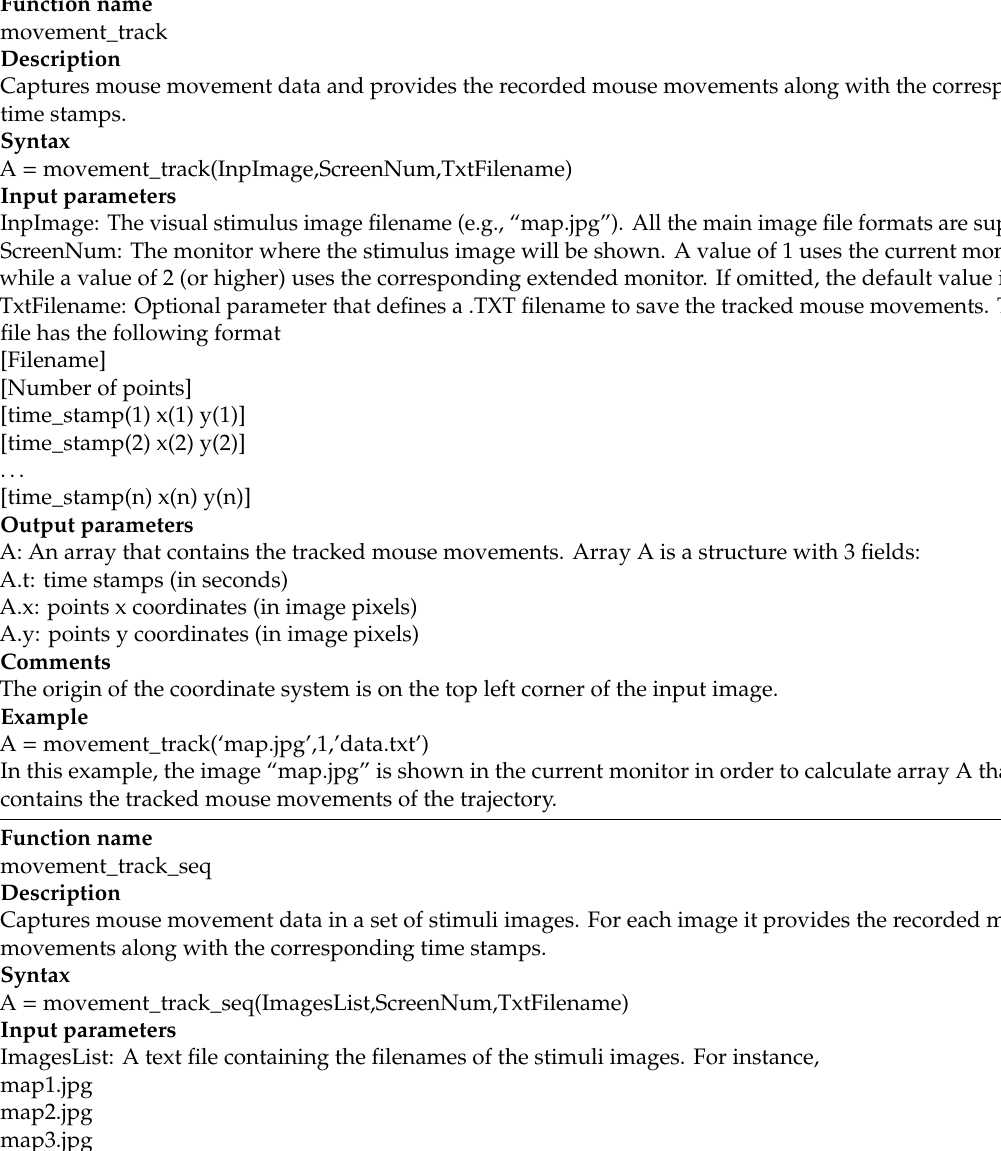
Table 1. MatMouse functions and example